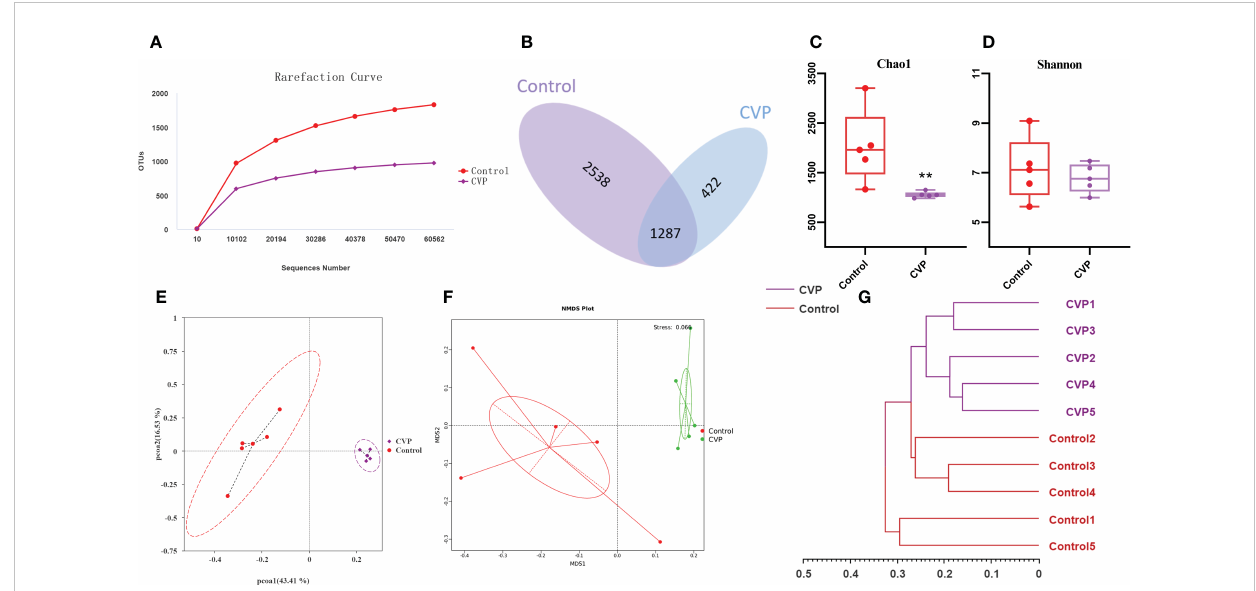
FIGURE 6 CVSS polysaccharides modulate the composition and structure of gut micro fl ora. (A) OUT Rarefaction Curves of gut microbiota in different groups; (B) Venn diagram showing the unique and shared OTUs from different groups; (C) Bacterial community richness measured by Chao1 index in different groups; (D) Bacterial community diversity measured by Shannon index in different group; (E) Unweighted Unifrac Principal Coordinate Analysis by bacterial microbiota; (F) NMDS ordination based on Bray-Curtis similarities of bacterial communities; (G) UPGMA clustering tree based on unweighted Unifrac distances. “ * ” stands for the comparation with Control; ** p <0.01 by one-way